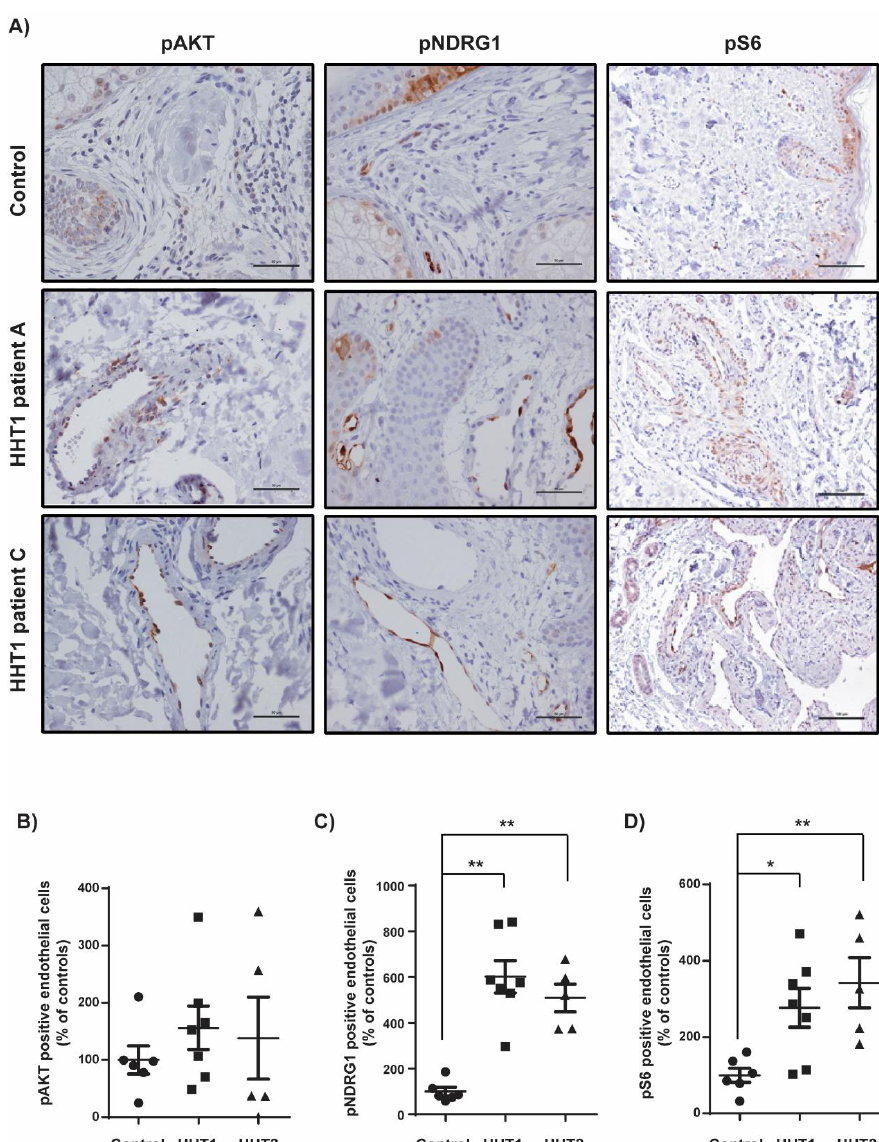
Figure 4. Increased activation of PI3K signaling in HHT1 cutaneous telangiectasia biopsies. ( A ) pAKT, pNDRG1, and pS6 staining of a control and two HHT1 patient biopsies. Scale bars, 100 µm. ( B ) Quantification of the percentage of pAKT-positive endothelial cells in controls (n = 6), HHT1 patients (n = 7), and HHT2 patients (n = 4). Results are represented as % relative to the control. Error bars indicate the standard error of the mean. ( C ) Quantification of the percentage of pNDRG1-positive endothelial cells in controls (n = 6), HHT1 patients (n = 7), and HHT2 patients (n = 5). Results are represented as % relative to the control. Error bars indicate the standard error of the mean. Statistical significance of two-tailed Mann–Whitney U tests: ** p < 0.01. ( D ) Quantification of the percentage of pS6-positive endothelial cells in controls (n = 6), HHT1 patients (n = 7), and HHT2 patients (n = 5). Results are represented as % relative to the control. Error bars indicate the standard error of the